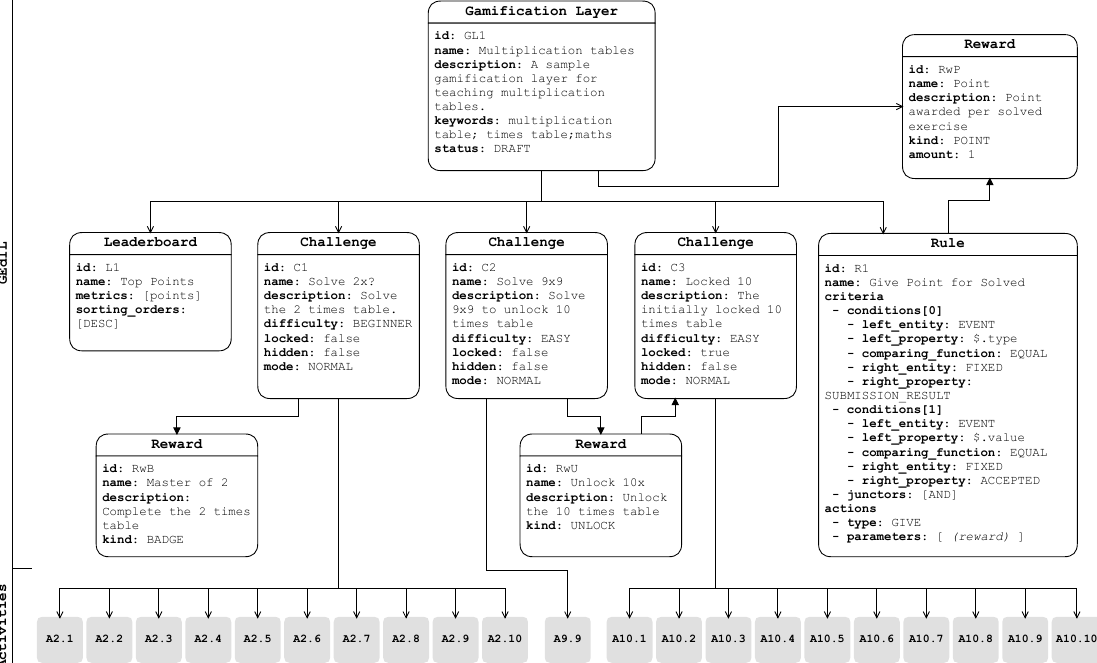
Figure 2. Diagram of the gamification layer of the toy domain (IDs masked for the sake of